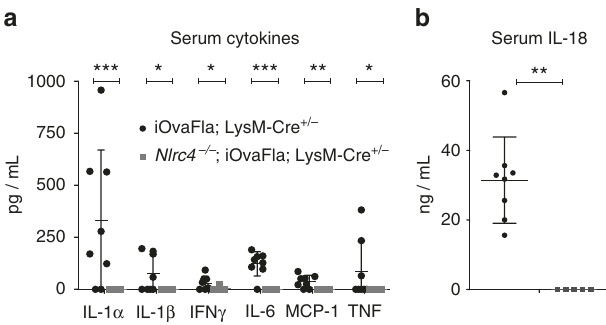
Fig. 4 iOvaFla: LysM-Cre +/ − mice have increased levels of in fl ammatory cytokines. a BD Biosciences cytokine bead array and b IL-18 ELISA with serum from 16-week-old iOvaFla; LysM-Cre +/ − and Nlrc4 − / − ; iOvaFla; LysM-Cre +/ − mice. Data are representative of three independent experiments. Error bars are s.d. Results were analysed with either a Mann – Whitney test or two-way ANOVA and Bonferroni post-tests; * p < 0.05, ** p < 0.01, *** p <